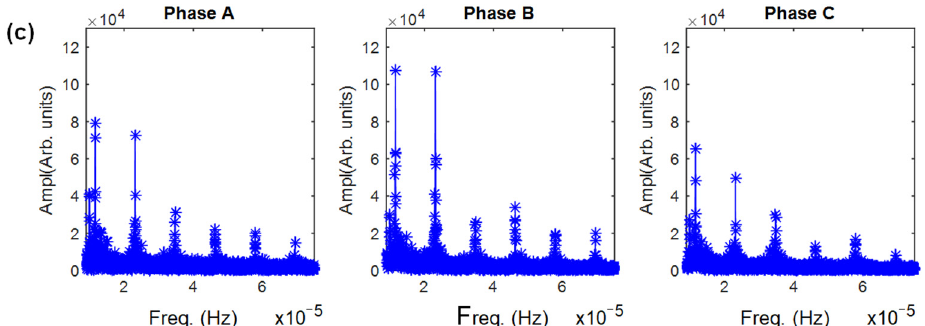
Figure 6. FFT of the currents flowing into the distribution circuits L1, L2, L3 for the whole period. ( a ) L1; ( b ) L2; and, ( c ) L3.